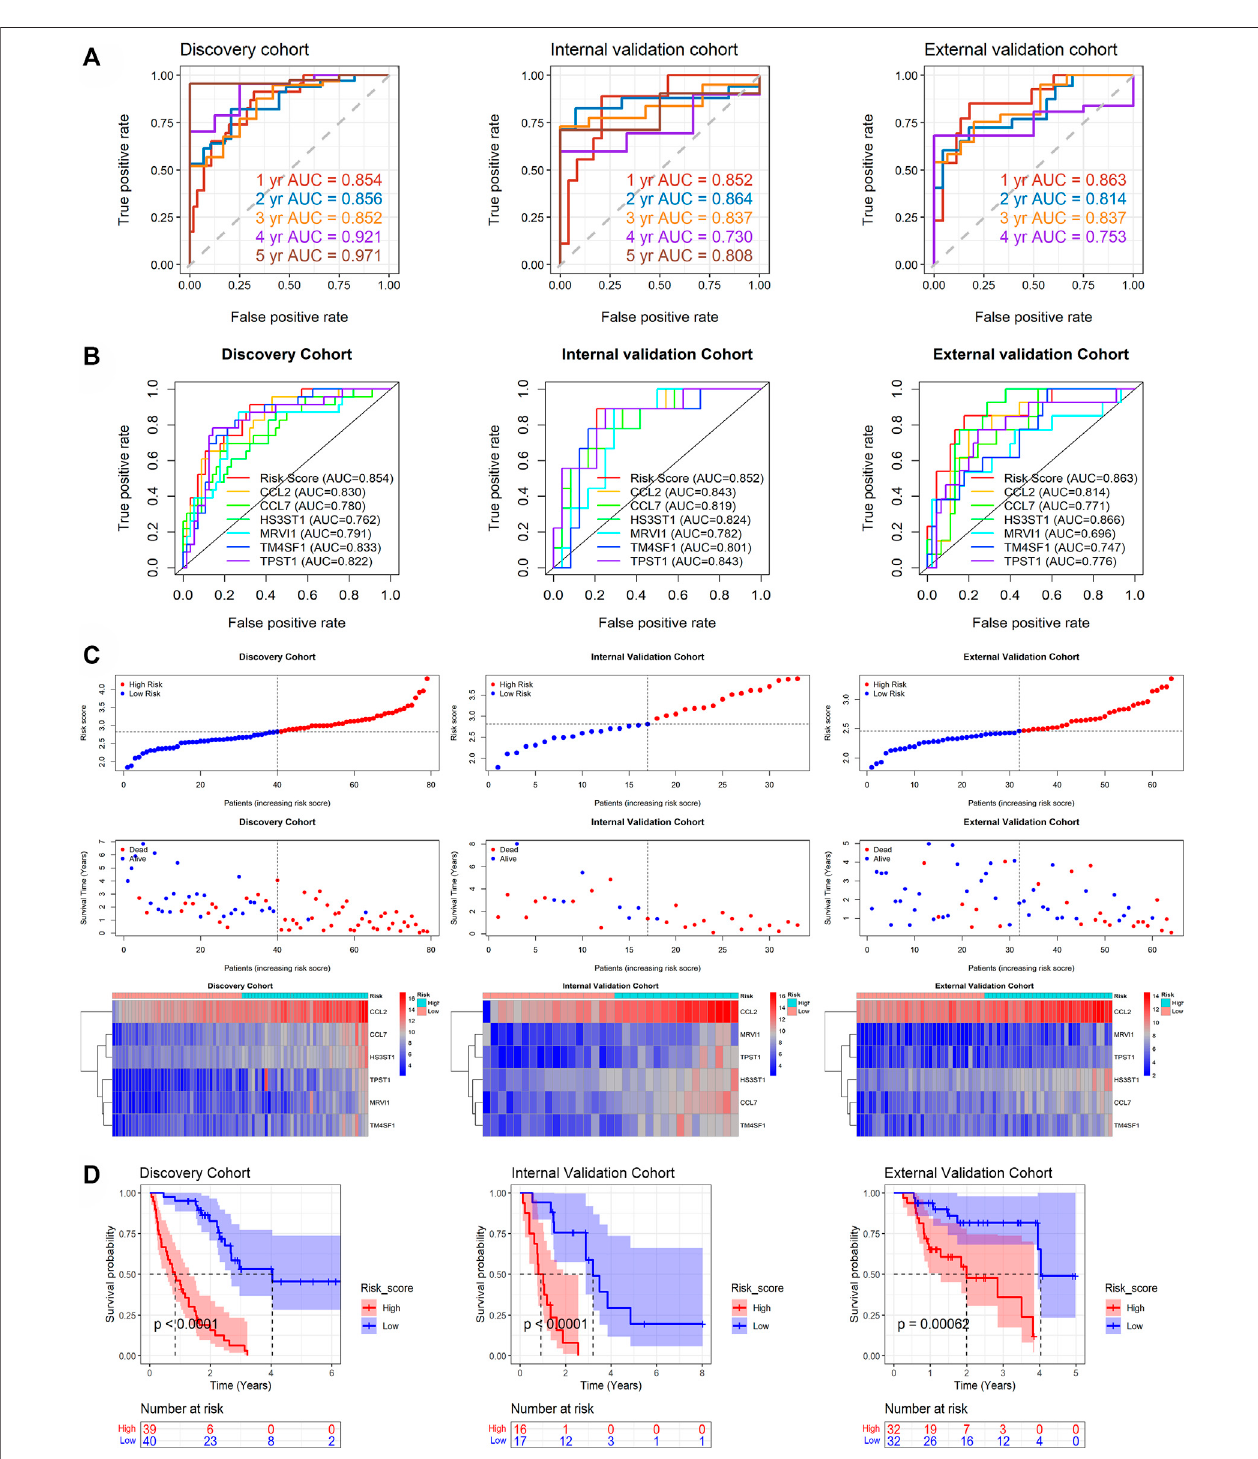
FIGURE4| The prediction accuracyand prognostic valueofm7GPSinIPF. (A) The accuracy ofm7GPSin predicting the 1-,3-,and 5-yearsurvival status (alive or dead)ofIPFpatients. (B) Theaccuracyofm7GPSandsinglegeneinpredictingthe1-survivalstatusofIPFpatients. (C) Riskplotsandheatmapsoftheexpressionpro fi le ofm7GPSandclinicalcharacteristics inthediscovery,internalvalidation,and externalvalidationcohorts. (D) Thedifferentprognosisbetweenthehigh-risk(patientswith ariskscorelessthanthemedianvalueofthecohort)andlow-risk(theotherpatients)groupsofthediscovery,internalvalidation,andexternalvalidationcohorts;the p -value is calculated based on log-rank test.